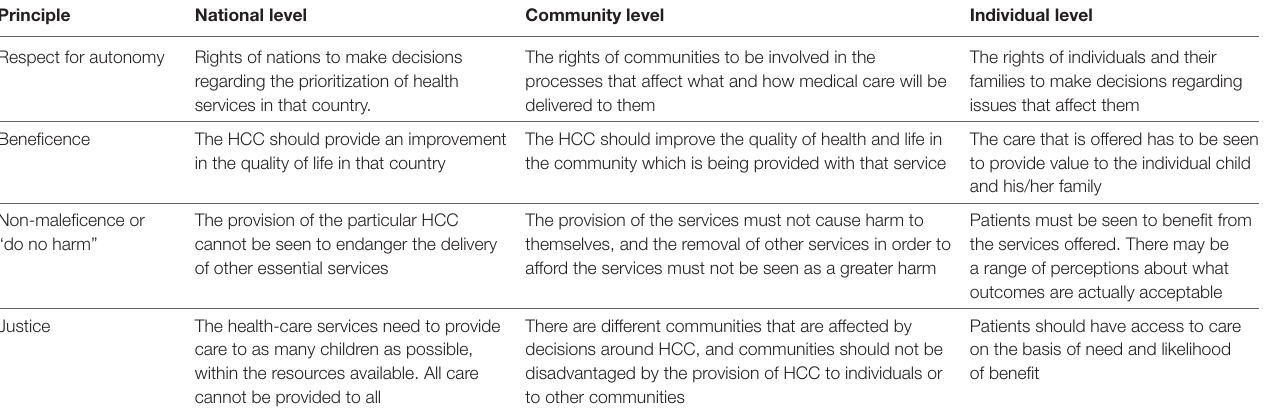
TAbLe 4 | Ethical principles to be applied in decision making around high-cost care (HCC).